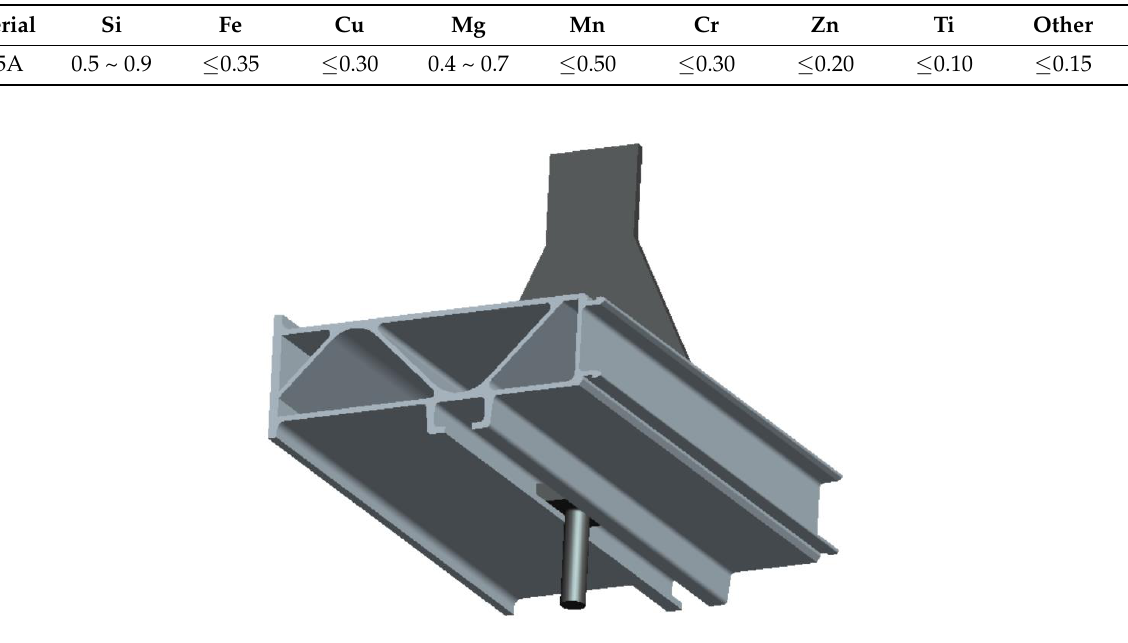
Figure 3. Three-dimensional solid model of the suspension structure.